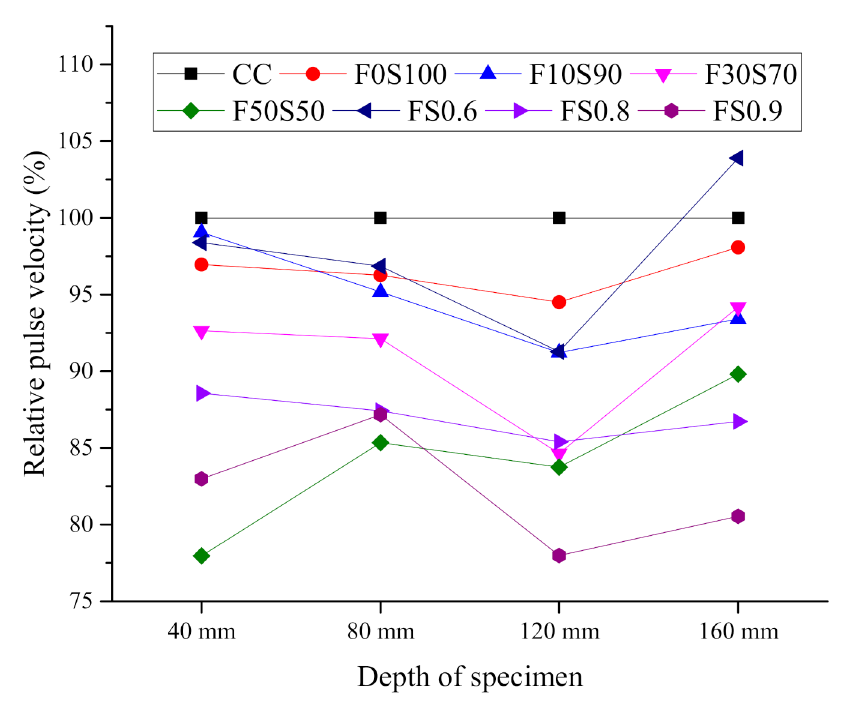
Figure 6. Filling capacity of grout mixes evaluated by relative pulse velocity at different depth of